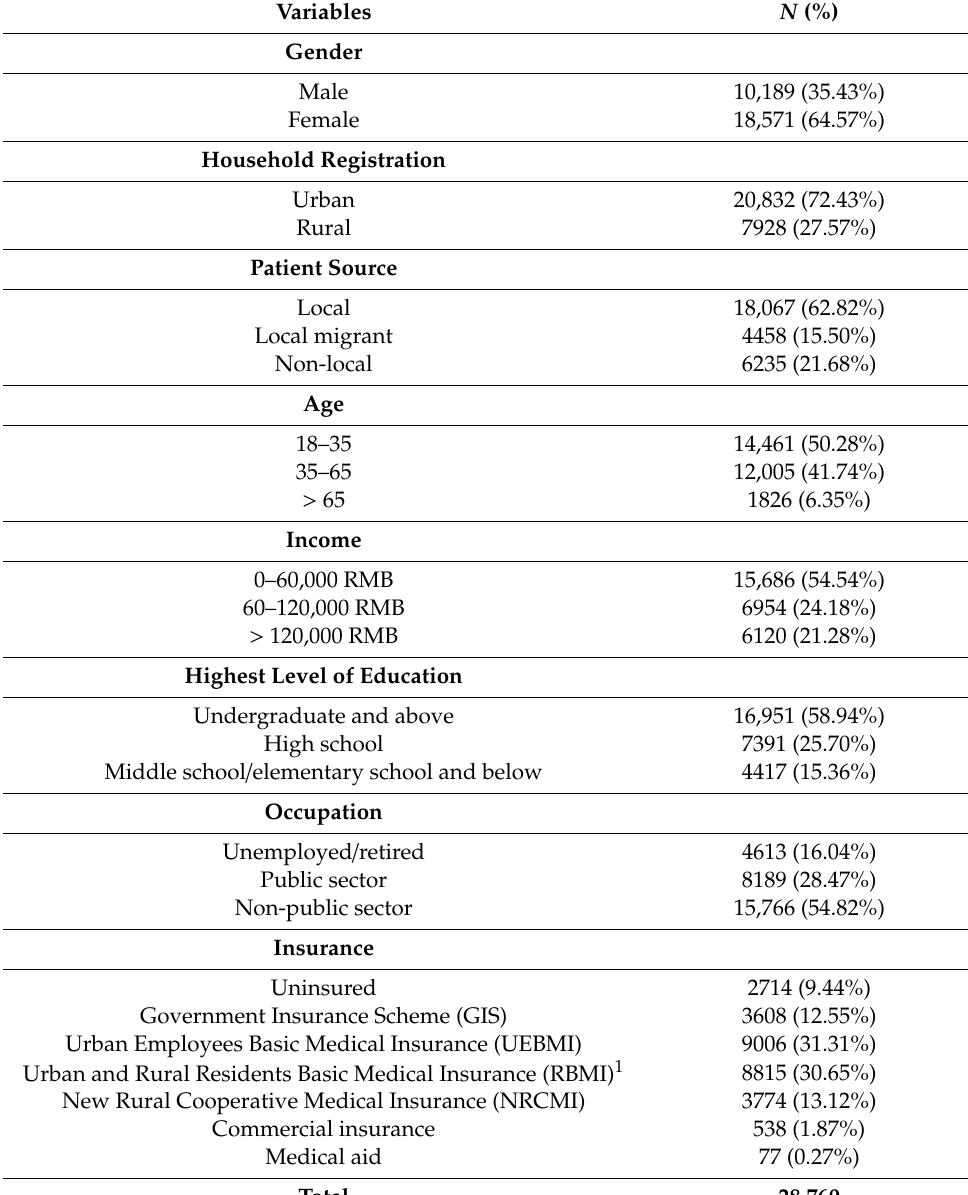
Table 2. Descriptive summary of key sociodemographic outpatient